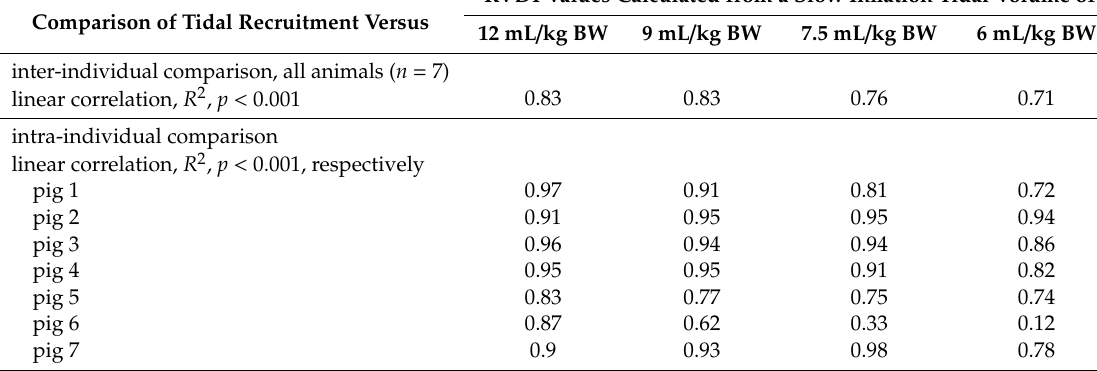
Table 2. Linear correlation of tidal recruitment and RVDI values obtained from di ff erent slow inflation V T maneuvers. Comparison of Tidal Recruitment Versus inter-individual comparison, all animals ( n = 7) linear correlation, R 2 , p <